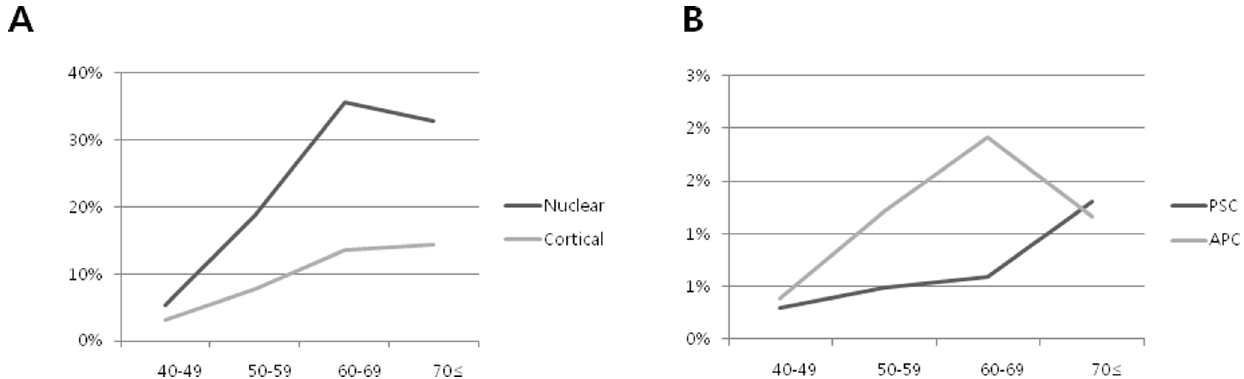
Figure 2. Linear graphs showing age distribution of cataract. (A) Age distribution of nuclear cataract and cortical cataract in Korean population. Both types of cataract show a highest incidence at the age of 60–69. (B) Age distribution of posterior subcapsular cataract (PSC) and anterior polar cataract (APC). PSC shows a gradual increase according to age, and APC present a highest peak at the age of 50–59. * PSC=posterior subcapsular opacity; APC=anterior polar